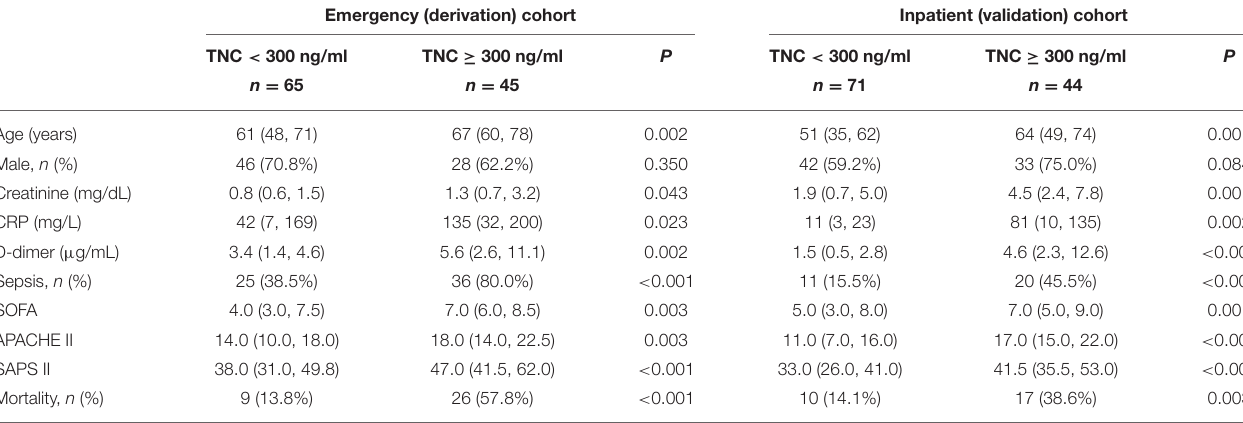
TABLE 3 | Comparisons between patients with serum TNC ≥ 300 ng/ml and serum TNC < 300ng/ml.